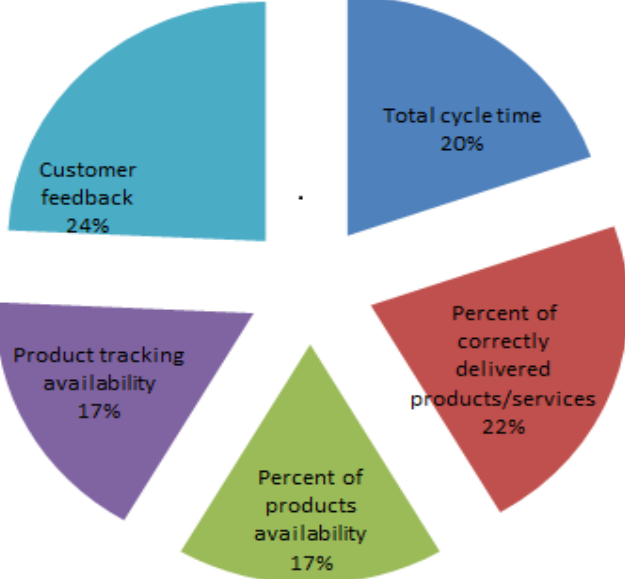
Figure 3. Strategies used for evaluating logistic customer service